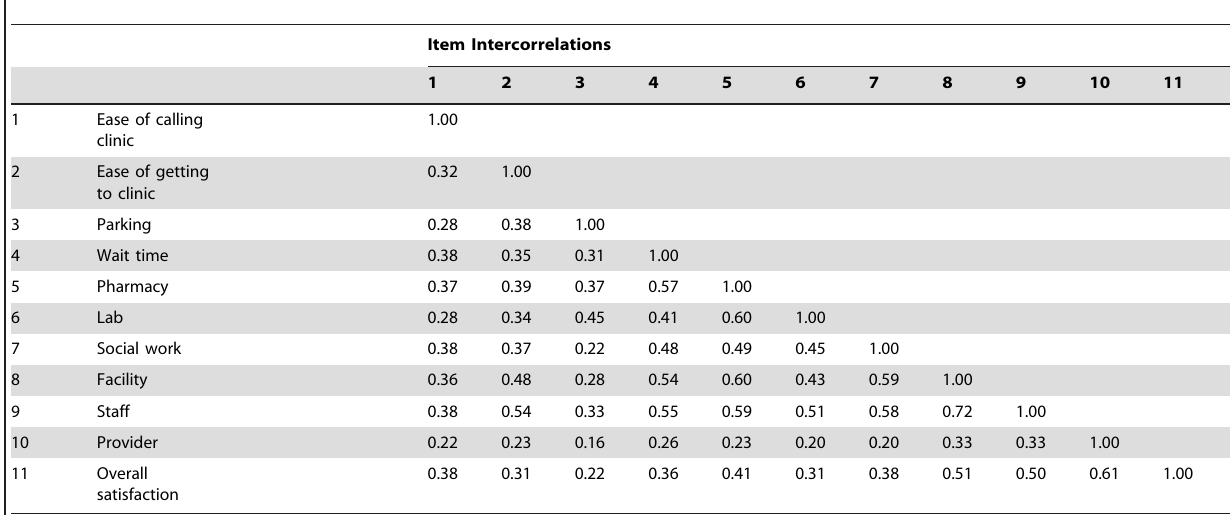
Table 2. Item intercorrelations of patients’ component experiences and overall